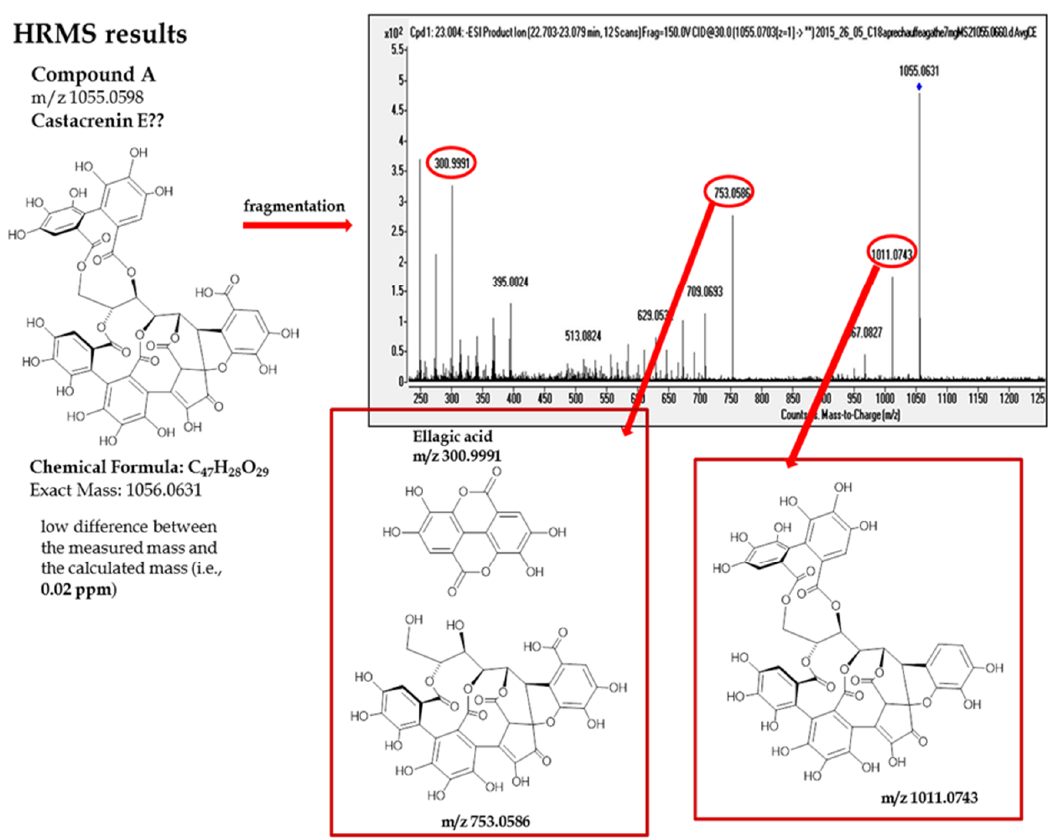
Figure 3. Major fragments of compound A.